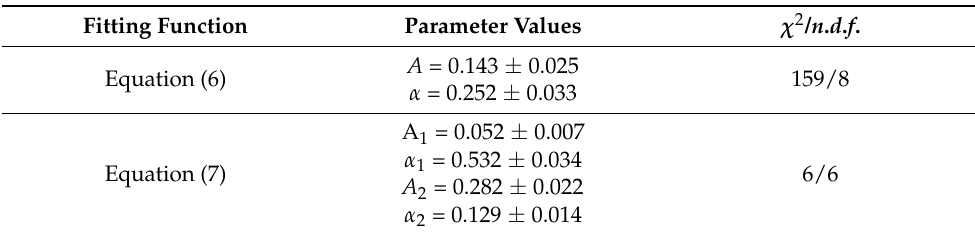
Table 4. The results of minimum χ 2 fits with the functions in Equations (6) and (7) of (cid:104) β T (cid:105) versus (cid:10) (cid:11) N part dependence in Figure 3b, obtained using consistent Tsallis function with transverse flow (Equation (5)).